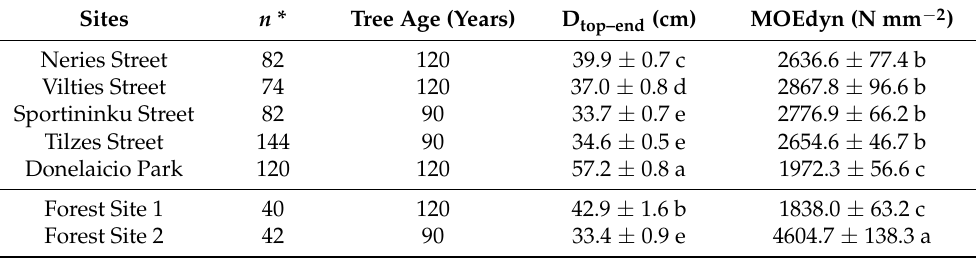
Table 1. Mean top-end diameter (D top–end , cm) and the dynamic modulus of elasticity (MOEdyn, N mm − 2 ) of small-leaved lime trees from different sites. The std. error of the mean is given next to the mean. Different letters indicate statistically significant differences between the sites at p < 0.05